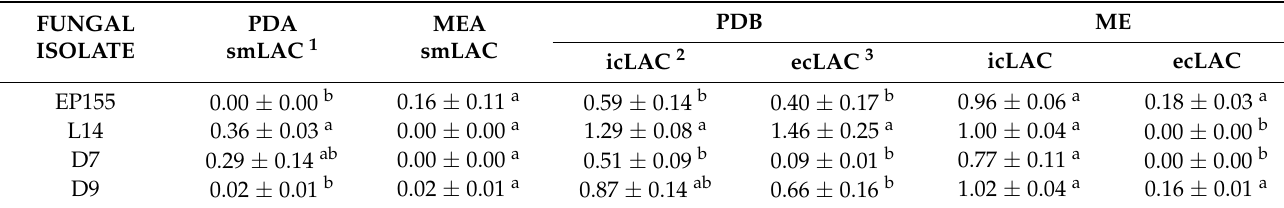
Table 3. The laccase activities of four virus-free fungal isolates after 10 days of growth on different media, that is, solid potato dextrose agar (PDA) and malt extract agar (MEA), liquid potato dextrose broth (PDB) and malt extract (ME). Laccase activity is expressed as nmol of generated DMOPox per minute per mg of mycelium dry weight. Data represent the mean of three replicates ± standard error. Letters denote statistically significant differences between values in the same column, that is, fungal isolates grown on the same medium, at p <